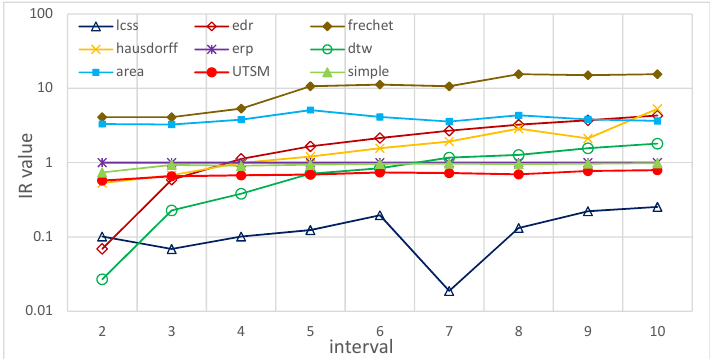
Figure 16. IR under different resample